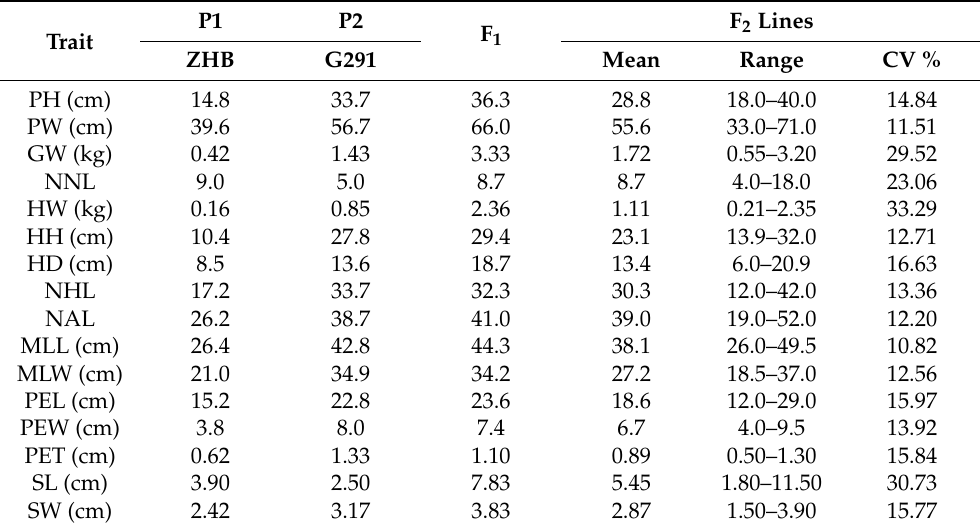
Table 3. Overview of the phenotypic traits in the parental, F 1 , and F 2 lines used for mapping construction and QTL mapping in Brassica rapa